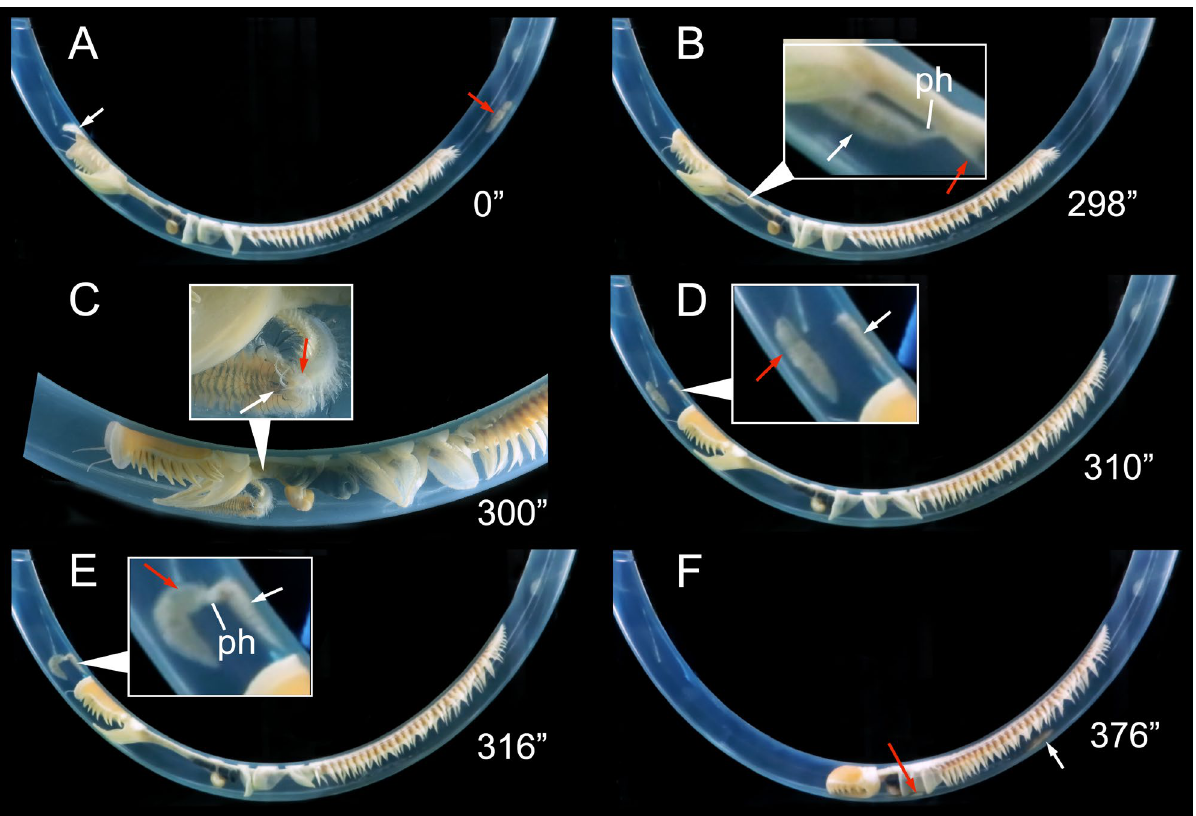
Figure 5. Sequence of two territorial attacks between a small resident and a large intruder Ophthalmonoe pettiboneae ; see Supplementary material S7. ( A–C ) Small resident attacking the large intruder: ( A ) resident near the host head, intruder just entered the tube; ( B ) Resident just attacked the intruder; ( C ) resident and intruder curling one over the other during the attack. ( D–E ) Large intruder attacking and driving out the small resident: ( D ) intruder approaching the resident; ( E ) Intruder attacking the resident; ( F ) intruder in the typical position, resident moving, going towards the exhalant siphon to leave the tube. Ph: Pharynx. White arrows indicate the smallest resident; red arrows indicate the largest intruder. Time course indicated in